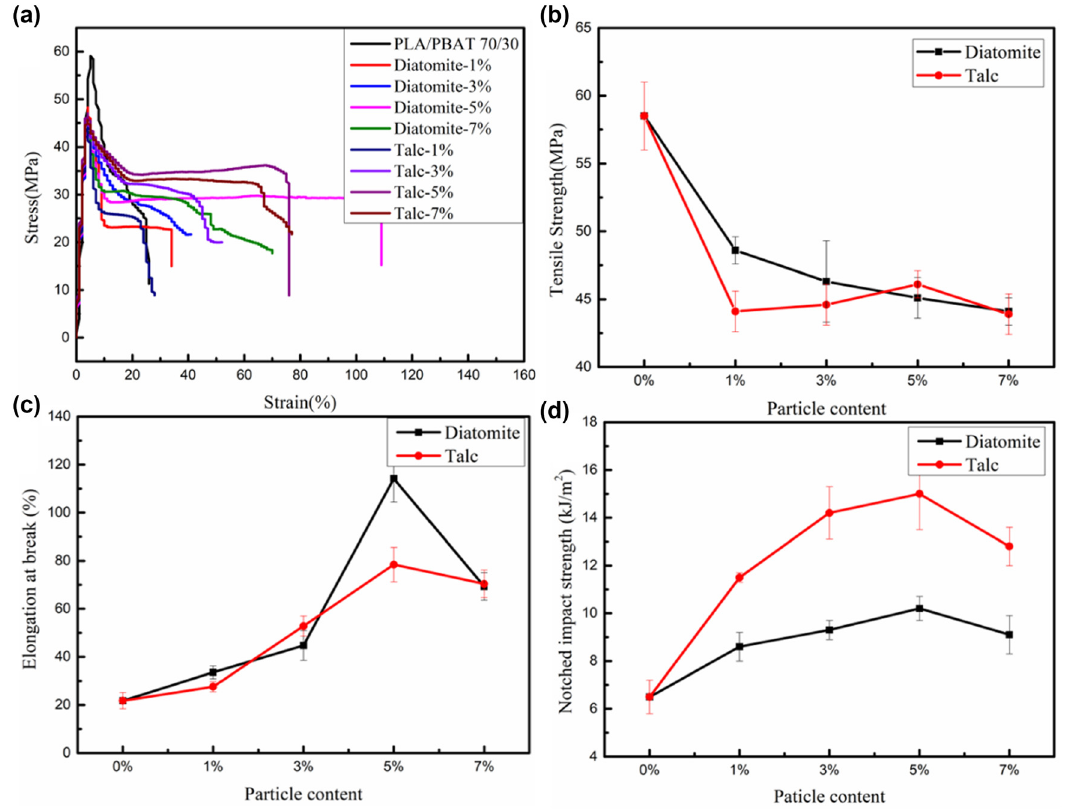
Figure 5: ( a ) Stress – strain curves, ( b ) tensile strength, ( c ) elongation at break, and ( d ) notched impact strength of the blends with talc and